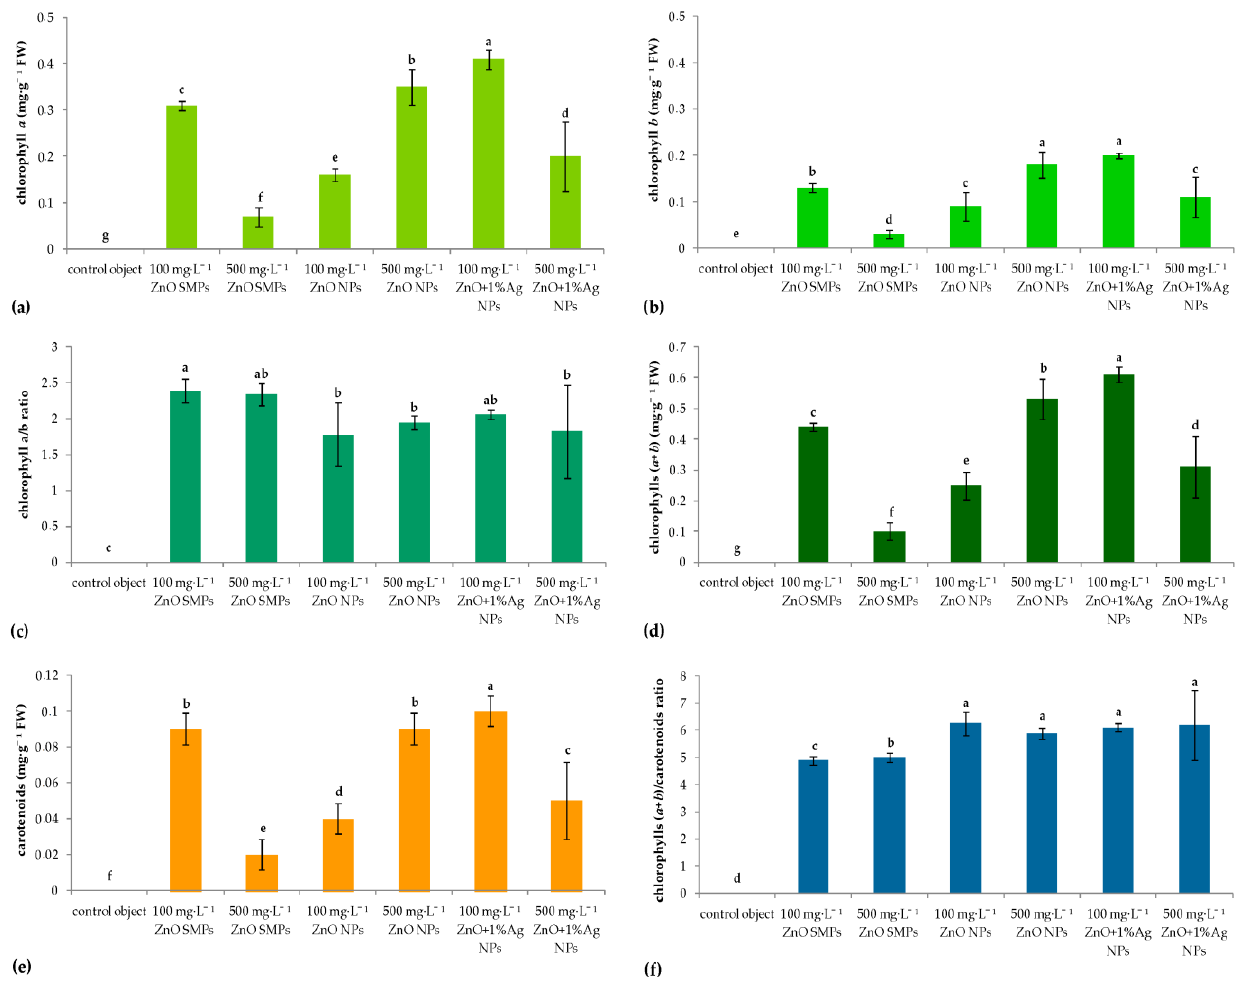
Figure 7. Content of metabolites (chlorophyll a , chlorophyll b ); ( a – d ), carotenoids; ( e , f ) in adventitious shoots of Chrysanthemum × morifloium ‘UTP Burgundy Gold’ regenerated from internodes cultured in vitro for 9 weeks on the modified MS medium with 0.6 mg·L −1 BAP and 2 mg·L −1 IAA, depending on the experimental treatment. Means ± SD on graphs followed by the same letter do not differ significantly at p ≤ 0.05 (Fisher’s test).